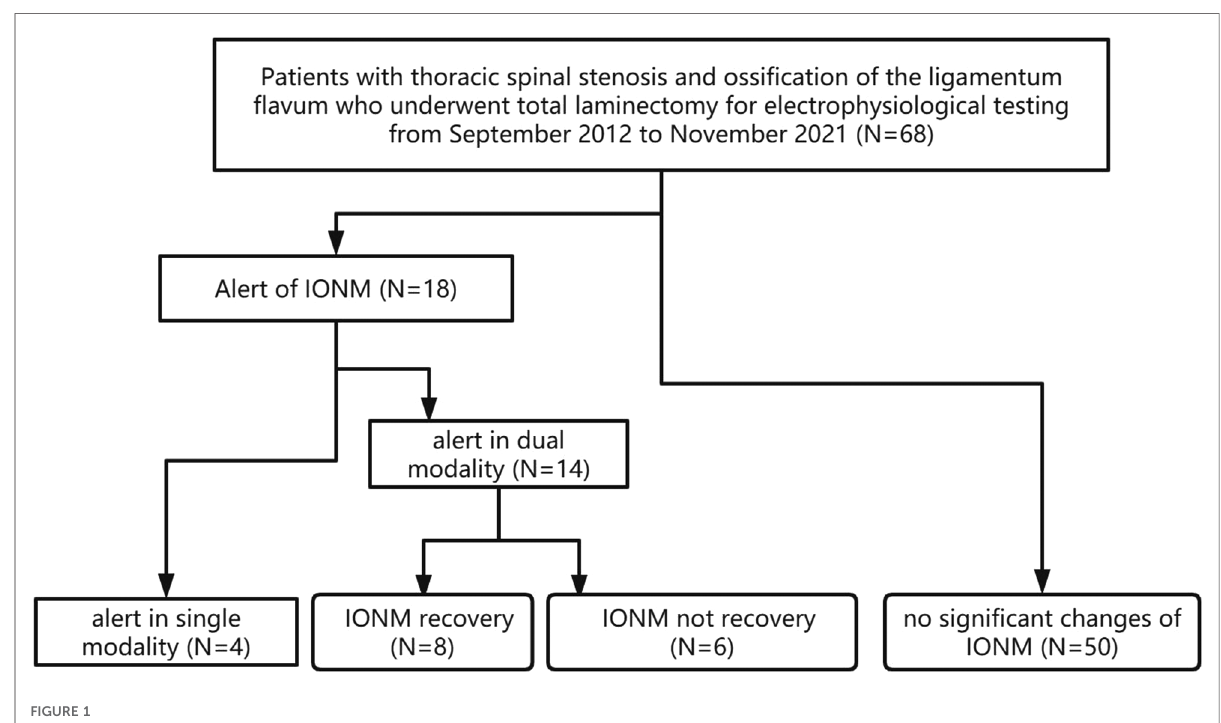
FIGURE 1 Flow diagram for patient